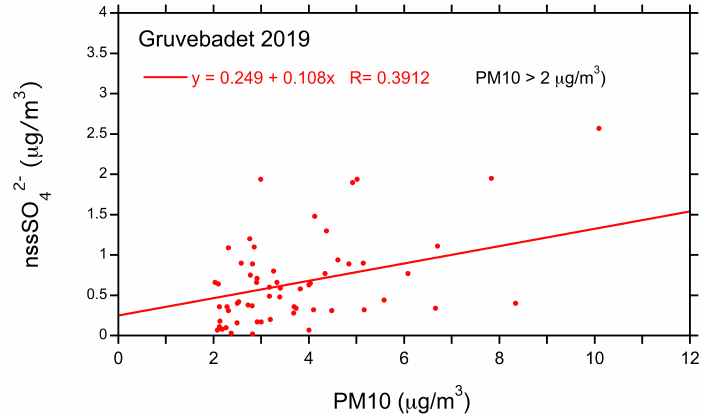
Figure 20. Relation between nss-SO 2 − PM10 load.